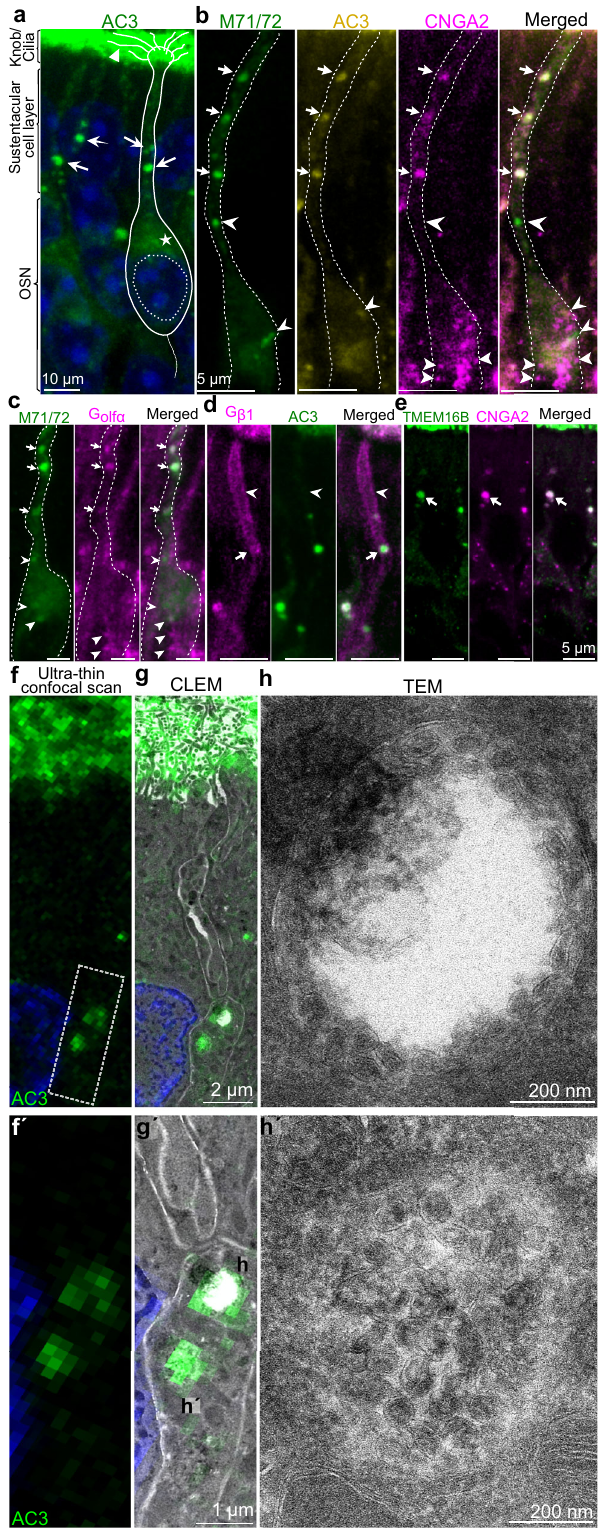
Fig.1|Identi fi cationofMVB-likeorganellescontainingseveralciliaryolfactory transductionproteins.a RepresentativeimageshowingAC3immuno fl uorescence in a coronal OE section imaged by confocal microscopy. The OE cell layers are indicated in the margin. The soma, nucleus, axon, dendrite, knob and cilia of one OSN are outlined. AC3 immuno fl uorescence is present in cilia (arrowhead), the soma (asterisk) and dendritic puncta (arrows). b , c Images of triple (2 mice; 18 OSNs) and double immunohistochemistry (3 mice; 30 OSNs) showing colocaliza- tionofM71/72,AC3andCNGA2( b )aswellasM71/72andG α olf( c )inthreedendritic puncta (arrows). In some puncta located in the soma and close to the dendritic origin, the fl uorescence did not overlap (arrowheads). d Results of double immu- nohistochemistry (2 mice; >30 OSNs) showing colocalization of G β 1 and AC3 in dendritic puncta (arrow). G β 1 but not AC3 was also present in the plasma mem- brane of the distal dendritic segment (arrowhead). e Images of double immuno- histochemistry(2mice;>25OSNs)showingcolocalizationofCNGA2andTMEM16B in dendritic puncta (arrow). f – h Representative images (4 mice; 17 OSNs) showing AC3 immuno fl uorescence ( f ) and CLEM images ( g ) of ultrathin (75nm) sections through an OSN dendrite. The outlined area in ( f ), which contains two immuno- fl uorescent puncta, is enlarged in f´ and g´. h TEM images showing that the two AC3-positive puncta ( h , h´ ) corresponded to MVB-like organelles. One MVB-like organelle lackedILVs in the center ( h ),whereasthe other wasdensely packed with ILVs (h´). An enlarge overview of ( g ) is shown in supplementary fi g.